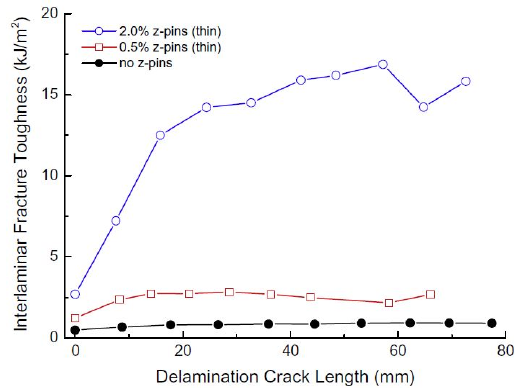
Figure 53. E ff ect of z-Pin content in R-curve on mode I apparent fracture toughness of a z-Pinned F igure 53. Effect of z-Pin content in R- F igure 54. Effect of z-Pin content in Paris F igure 53. Effect of z-Pin content in R- F igure 54. Effect of z-Pin content in Paris laminate (CFRP z-Pins, d = 0.28mm, [0 n [0 / 90]] s pre-preg) curve on mode I apparent fracture curves for mode I z-Pinned laminate curve on mode I apparent fracture curves for mode I z-Pinned laminate toughness of a z-Pinned laminate (CFRP z- (CFRP z-Pins, d = 0.28 mm, l = 4 mm, toughness of a z-Pinned laminate (CFRP z- (CFRP z-Pins, d = 0.28 mm, l = 4 mm, Pins, d = 0.28mm, [0 n [0/90]] s pre-preg) [33]. [0 n [0/90]] s pre-preg) [33]. [0 n [0/90]] s pre-preg) [33].